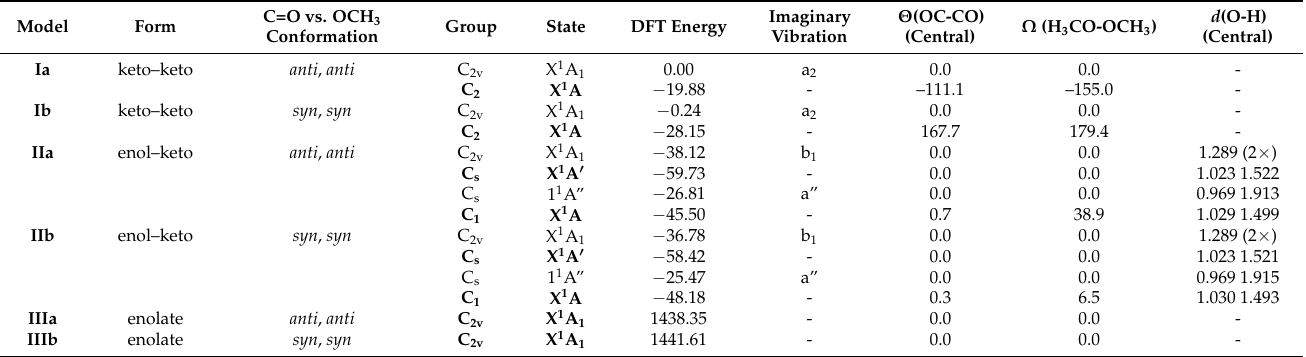
Table 1. Selected structural data and relative DFT energies (in kJ/mol) of optimized molecules for different electronic states. Stable structures are indicated by bold text. The dihedral angles (in degrees) are denoted by Greek symbols, distances d are in Å.